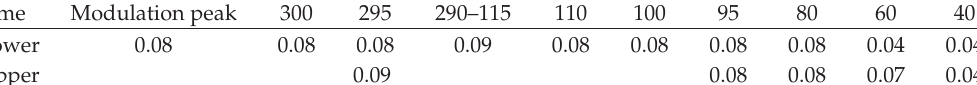
Table 3: The growth rates varying with time for case ε 0 (cid:7) 0 . 05 with r 1 (cid:7) 0 . 09.